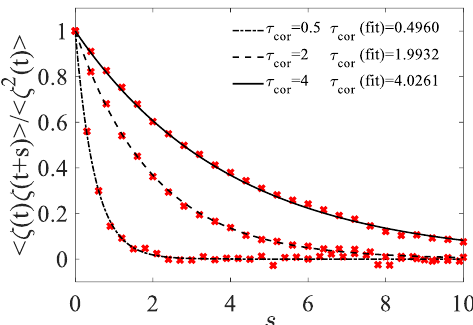
Figure 14. Plots of normalized correlation function for p = 0.4, ∆ = 5, for three different noise profiles with given correlation times τ = 0.5, 2 and 4. Colored markers are numerical results, and bold curves correspond to fitted results.